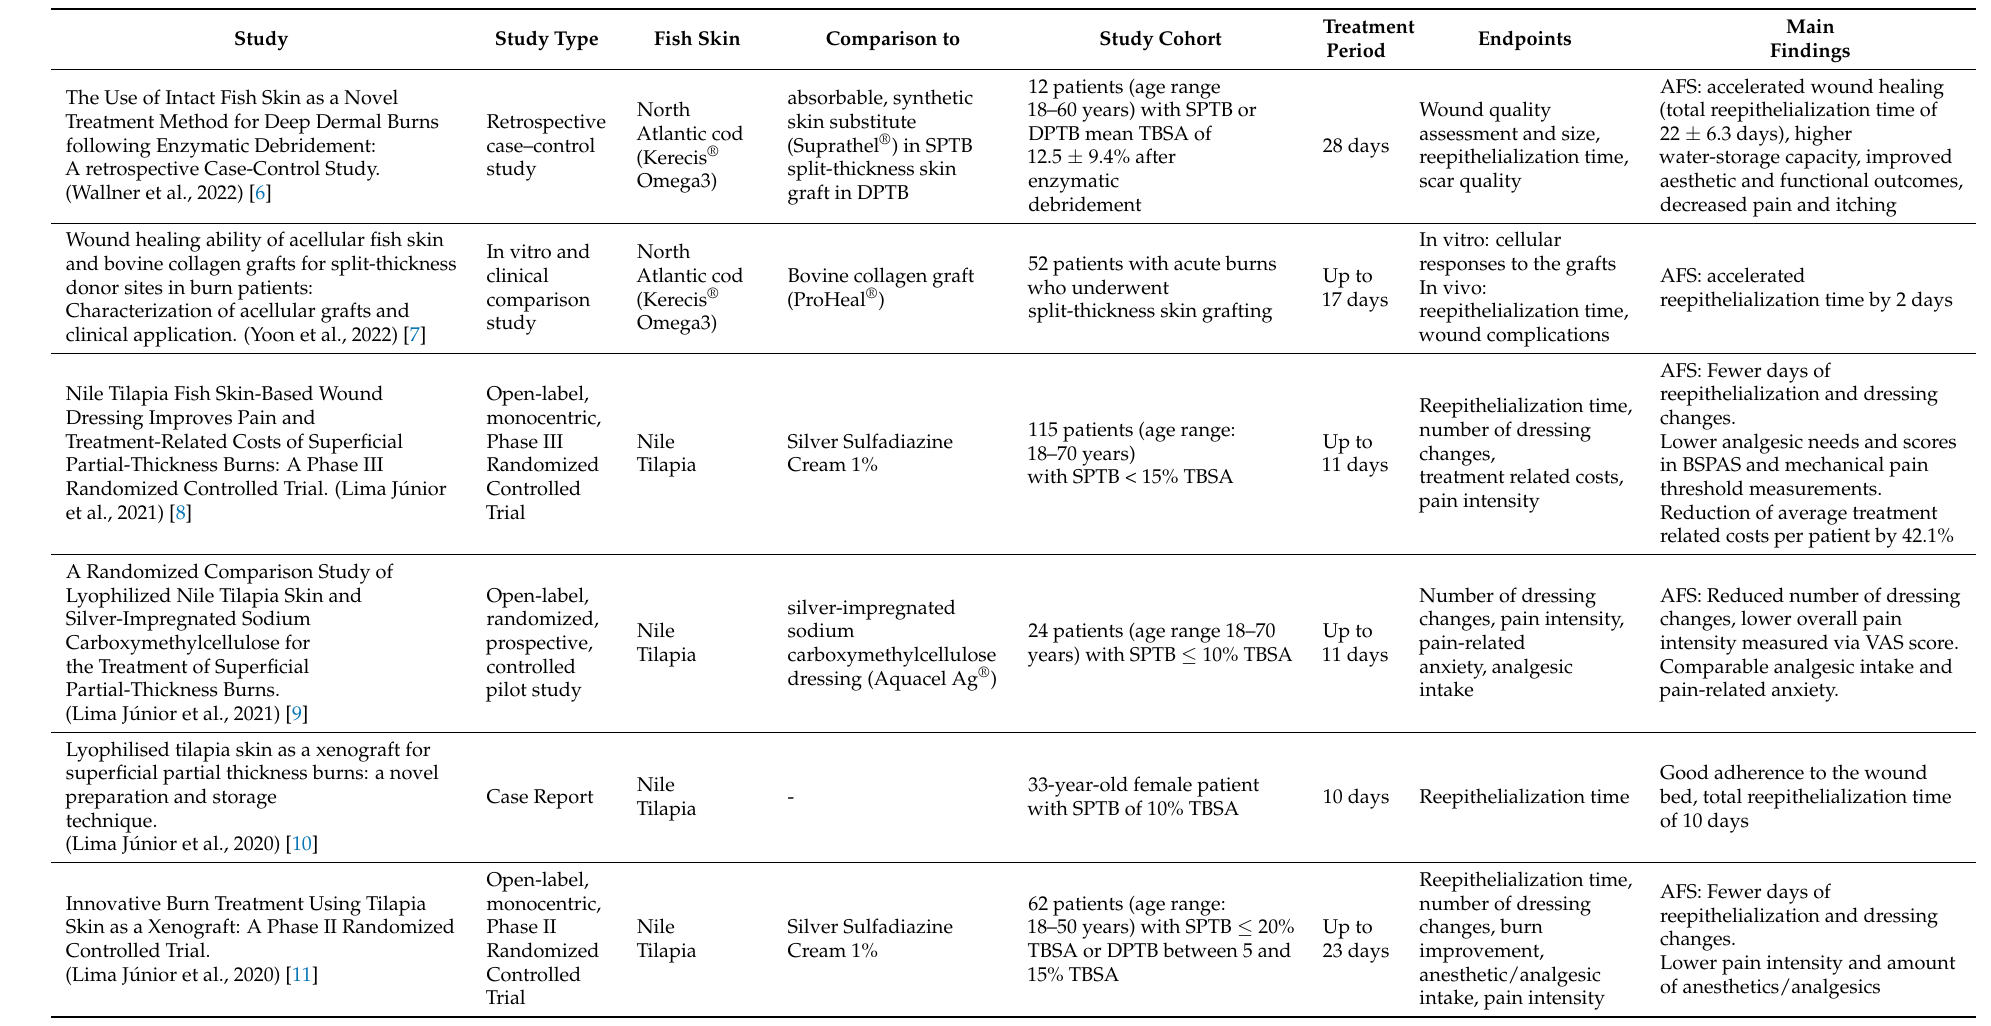
Table 2. Clinical studies evaluating the use of acellular fish skin in burn wounds and split-thickness donor